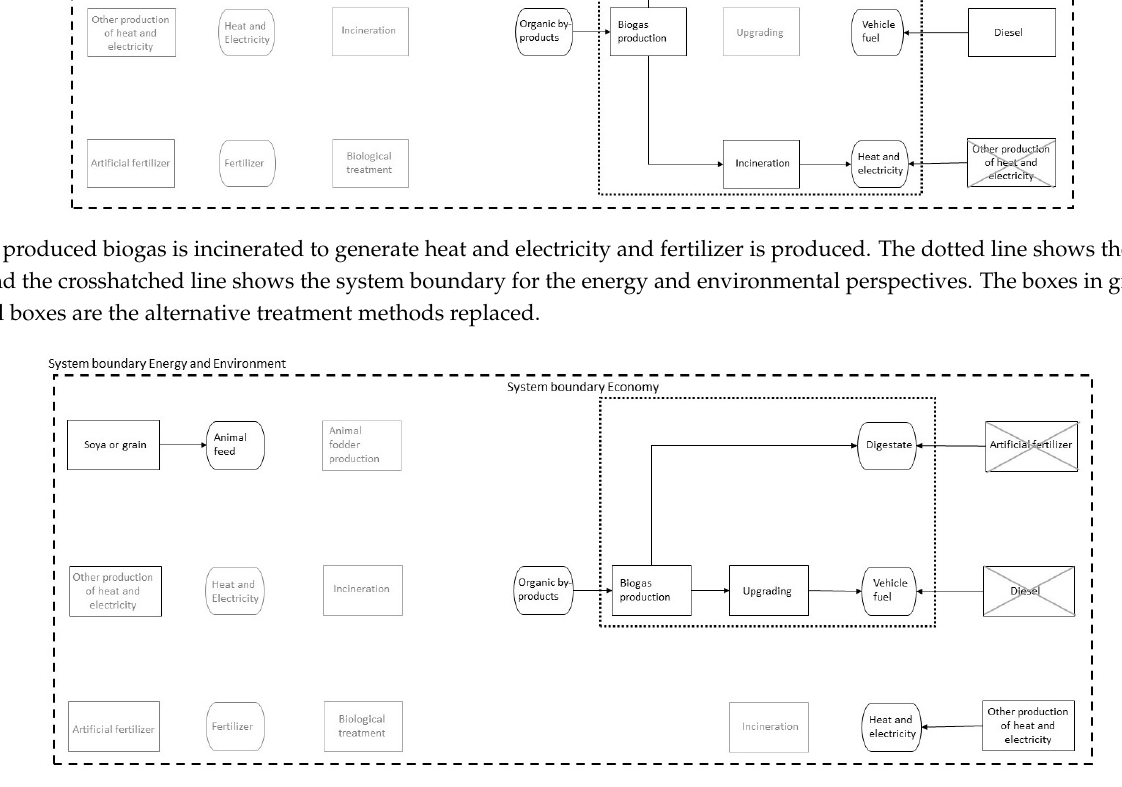
Figure 4. Scenario Vehicle produced biogas is upgraded to vehicle fuel and fertilizer is produced. The dotted line shows the system boundary for the economic perspective and the crosshatched line shows the system boundary for the energy and environmental perspectives. The boxes in grey are not included in the scenario and the crossed boxes are the alternative treatment methods replaced.